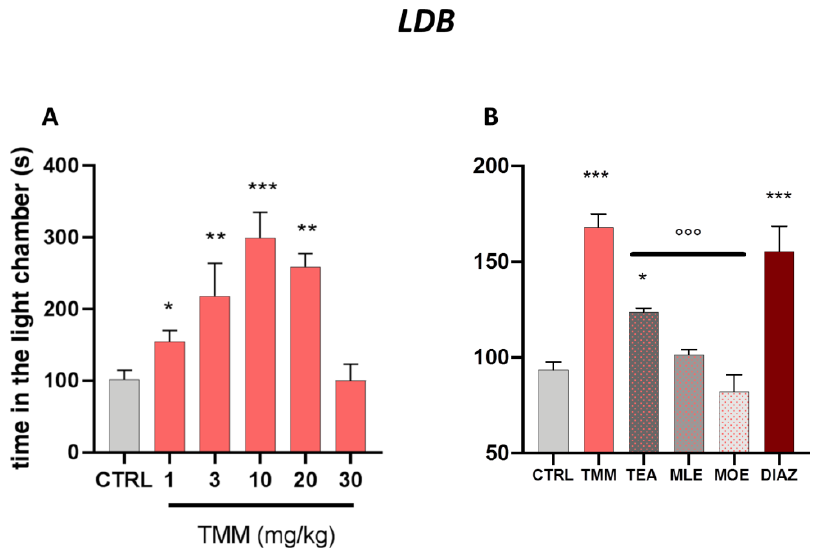
Figure 1. Dose–response curve obtained with the oral administration of different concentrations of TMM after 60 min in the light/dark (LDB) test ( A ). Comparison of the effect of TMM (10 mg/kg), L-theanine (TEA) (2.5 mg/kg), Melissa officinalis leaf extract (MLE) (0.625 mg/kg), and Magnolia officinalis bark extract (MOE) (0.25 mg/kg) in the L/D test ( B ). Diazepam (DIAZ) was used as a positive control. *** p < 0.001, ** p < 0.01, * p < 0.05 vs. CTRL; °°° p < 0.001 vs. TMM.